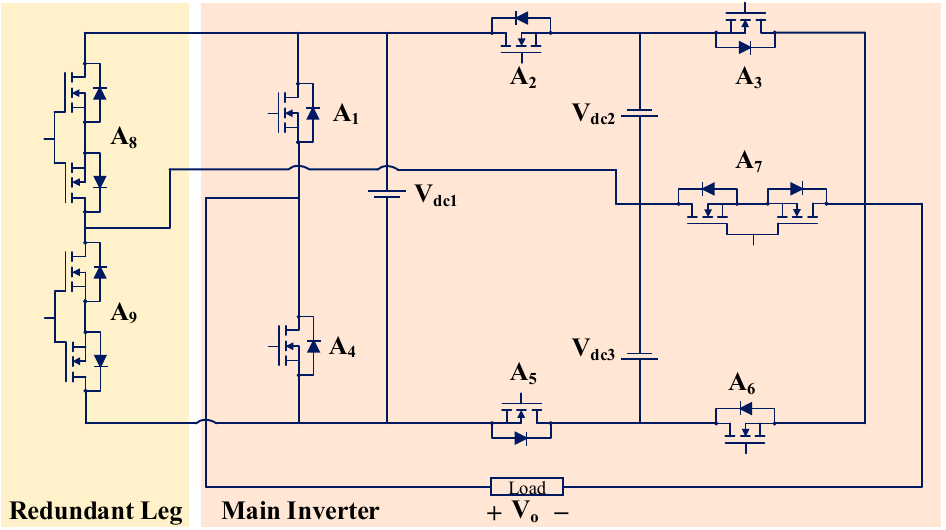
Figure 43. Single-phase nine-level FT MLI (TP46)